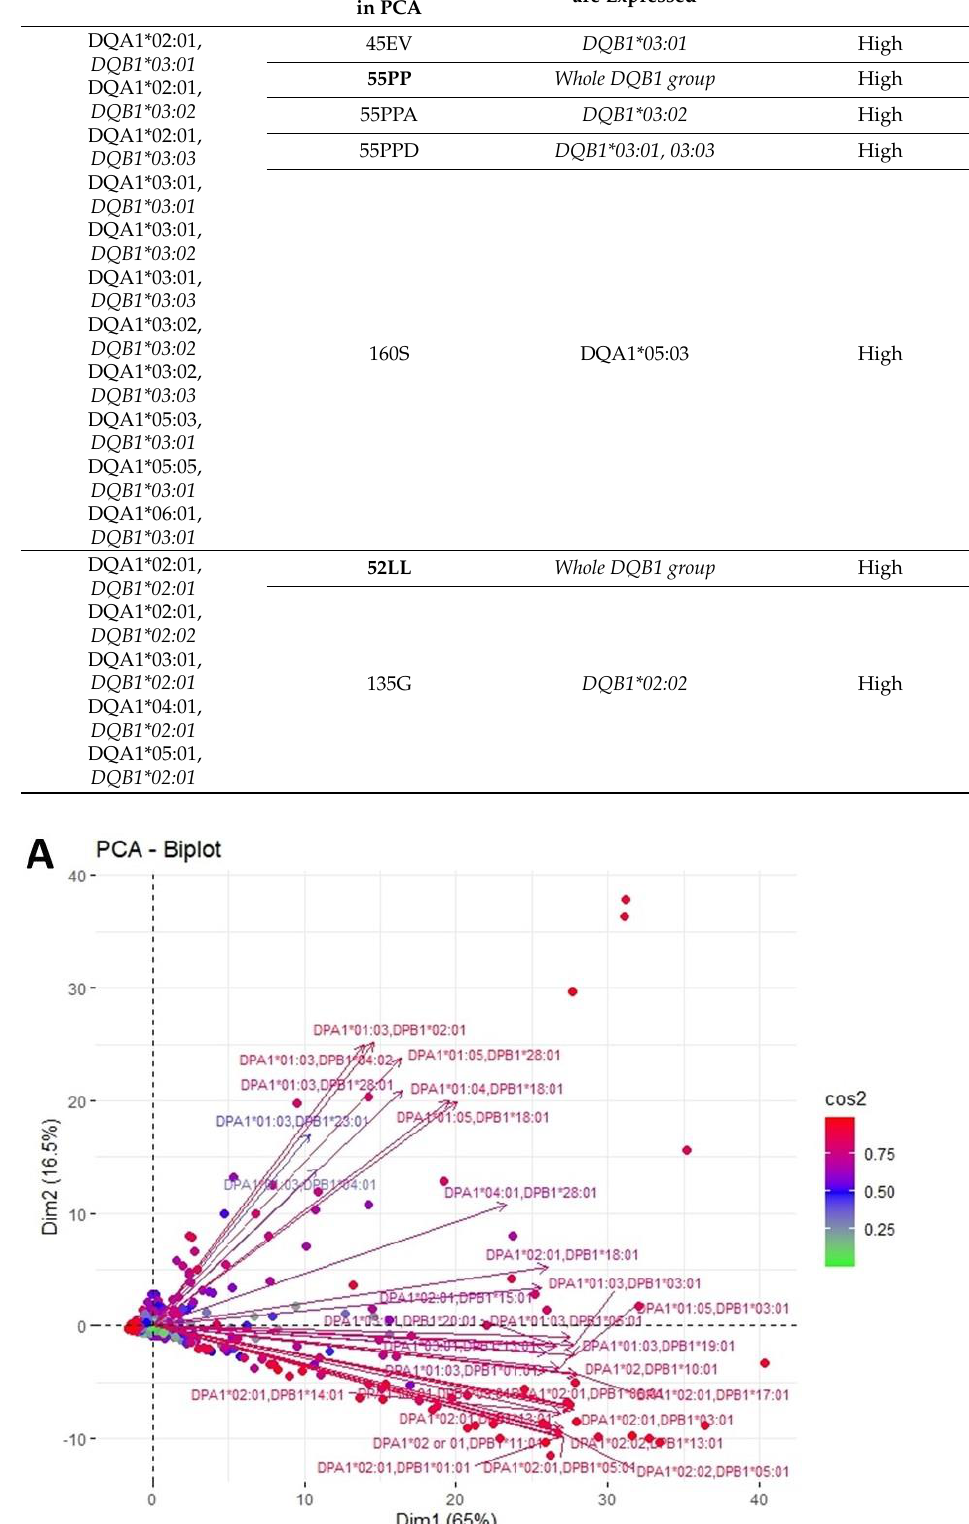
Figure 5. PCA biplot projections of anti-HLA-DP responses. ( A ) Projection of the first and second eigenvectors of the covariance matrix. ( B ) Projection of the second and third eigenvectors of the covariance matrix. Each arrow represents a specific anti-HLA-DR reaction, while each point indi- cates individual reactions. Colors of loadings and points represent the cos2 value of the explained variance for variables and individuals, respectively.